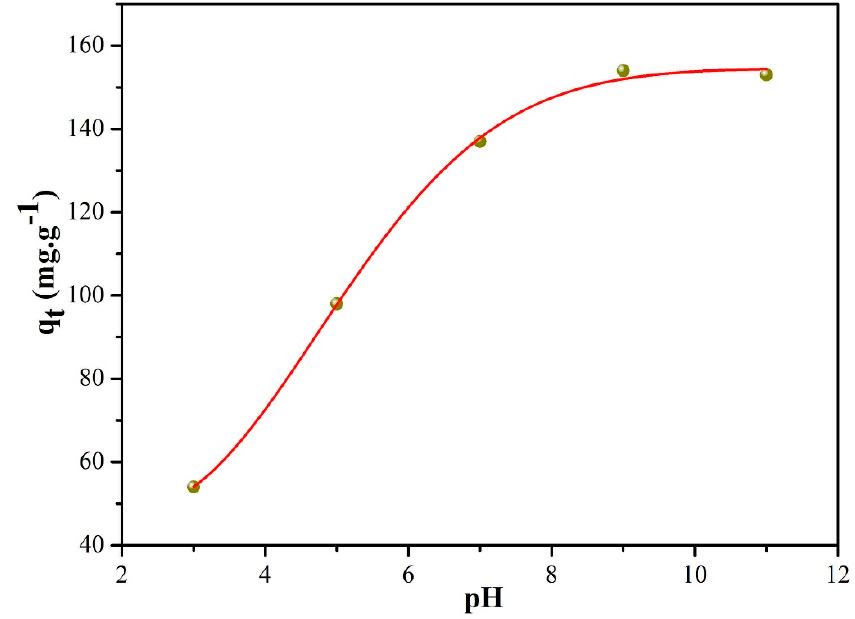
Figure 8. MB adsorption capacity of MnO-4 at different pH values.